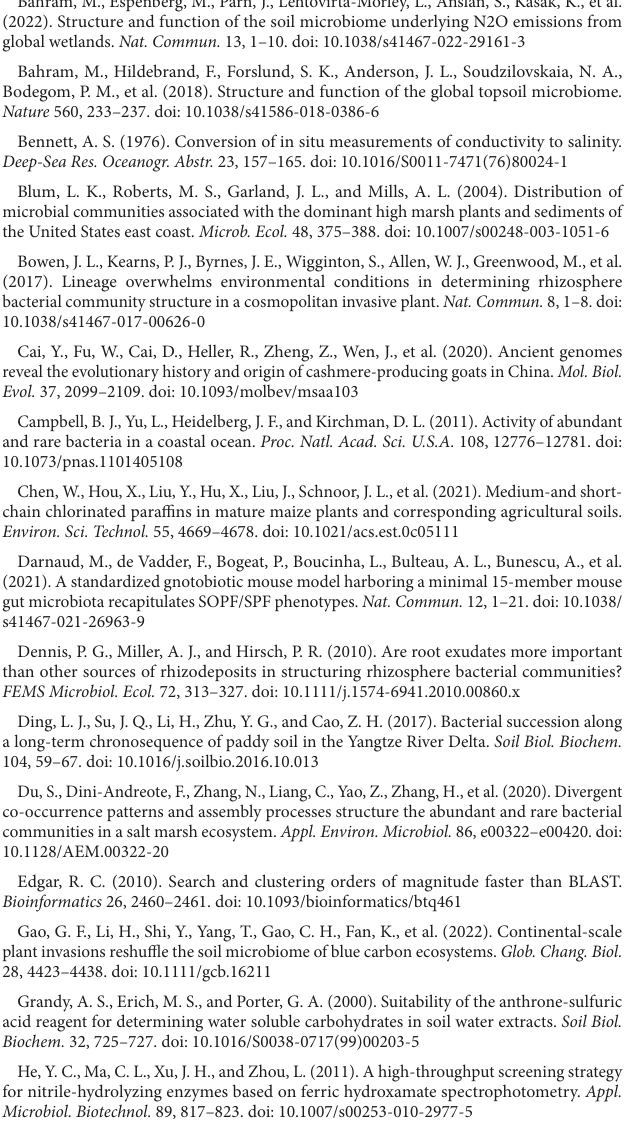
SUPPLEMENTARY FIGURE S1 The geographical location of the sampling sites. SUPPLEMENTARY FIGURE S2 Percentage of relative abundance of sequences of abundant, moderate, rare bacterial taxa in salt